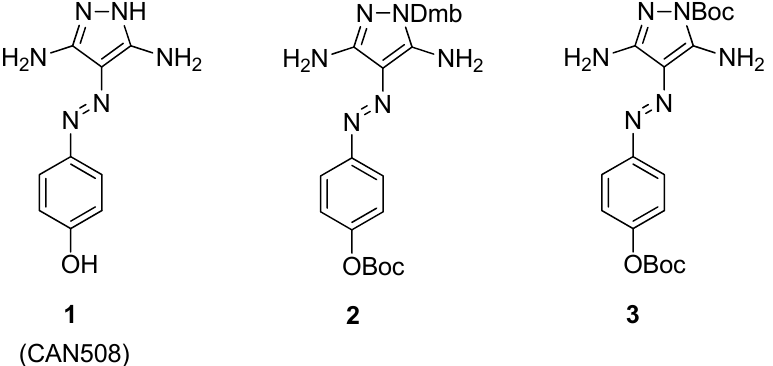
Figure 1. Derivatives of pyrazole 1 protected at the endocyclic pyrazole nitrogen and hydroxyl group. Molecules 2018 , 23 , 149;